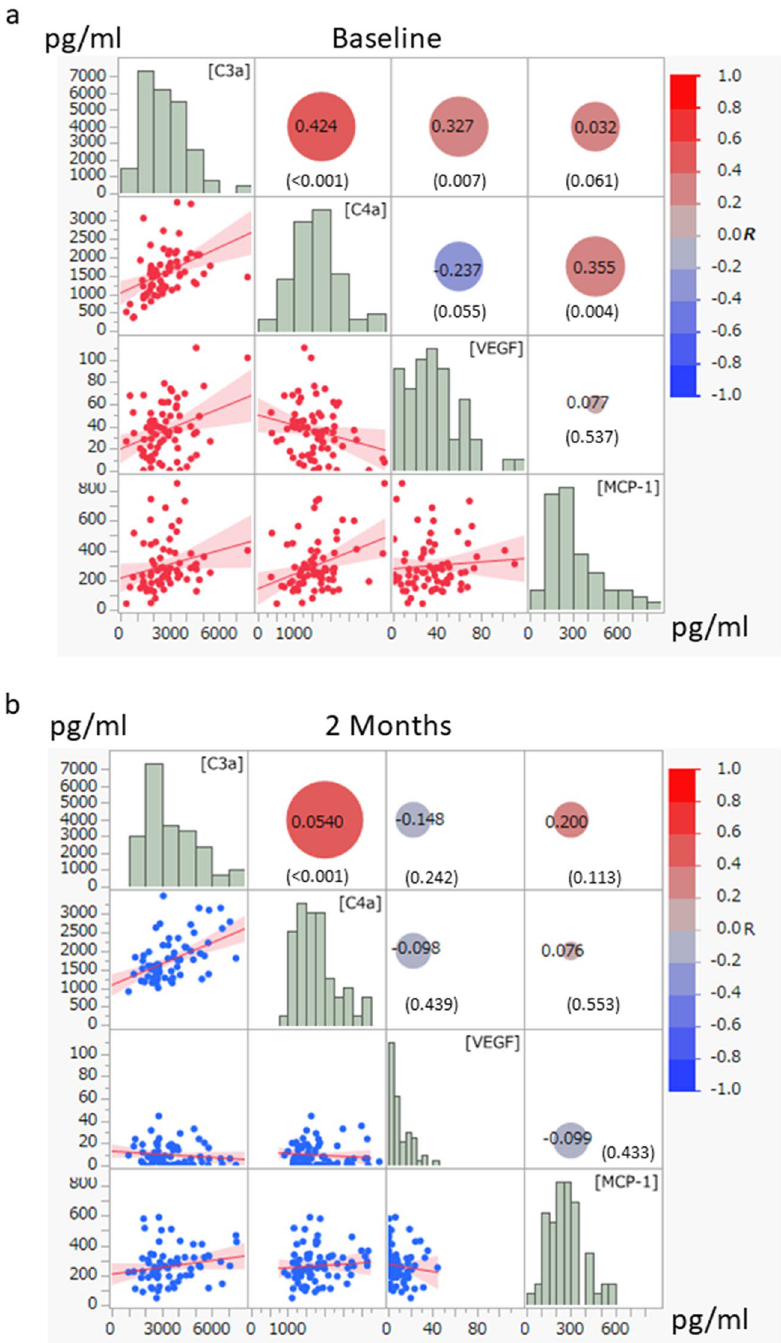
Figure 1. The correlation among complement factors and cytokines in the aqueous humor of eyes with choroidal neovascularization (CNV). Pearson’s correlation analysis was used. C3a, complement component 3a; C4a, complement component 4a; VEGF, vascular endothelial growth factor; MCP-1, macrophage chemoattractant protein 1. R, correlation coefficient. The scale of the axis is adjusted in the same range between ( a ) and ( b ). the sizes of the circles indicate the magnitude of the correlation; red circle, positive correlation; blue circle, negative correlation. Number in parenthesis indicates the P value of